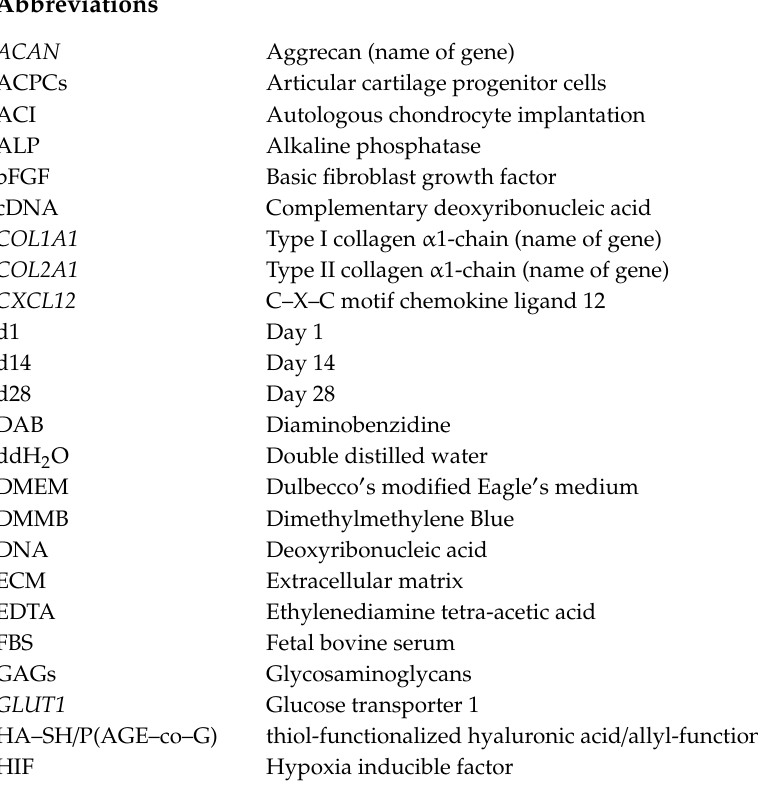
constructs. Figure S2: DNA content in ACPC, MSC, and zonal constructs under normoxic and hypoxic conditions. Figure S3: Live / dead staining. Figure S4: Staining of ACPC, MSC, and zonal constructs at d1 for type II and type I collagen. Figure S5: Staining of ACPC, MSC, and zonal constructs cultured under normoxic and hypoxic conditions for type VI collagen. Figure S6: Relative gene expression of HIF target genes in ACPC and MSC constructs. Table S1. Studies comparing ACPC chondrogenesis to other cell types in di ff erent hydrogels. Table S2. Primer sequences for RT-qPCR